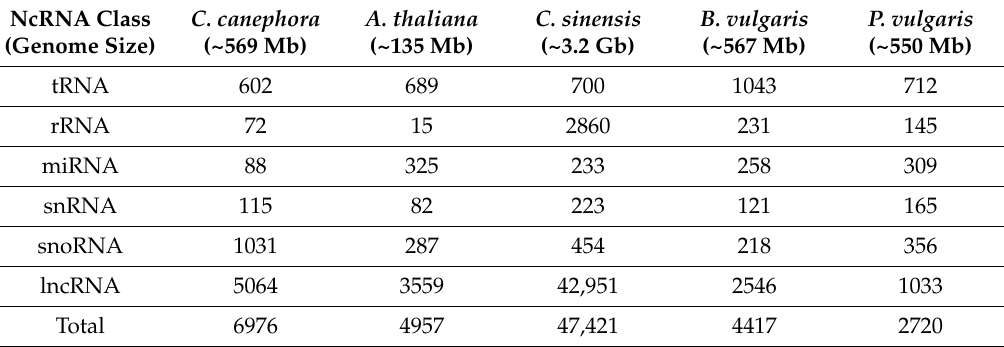
Table 1. Comparative analysis of C. canephora genome